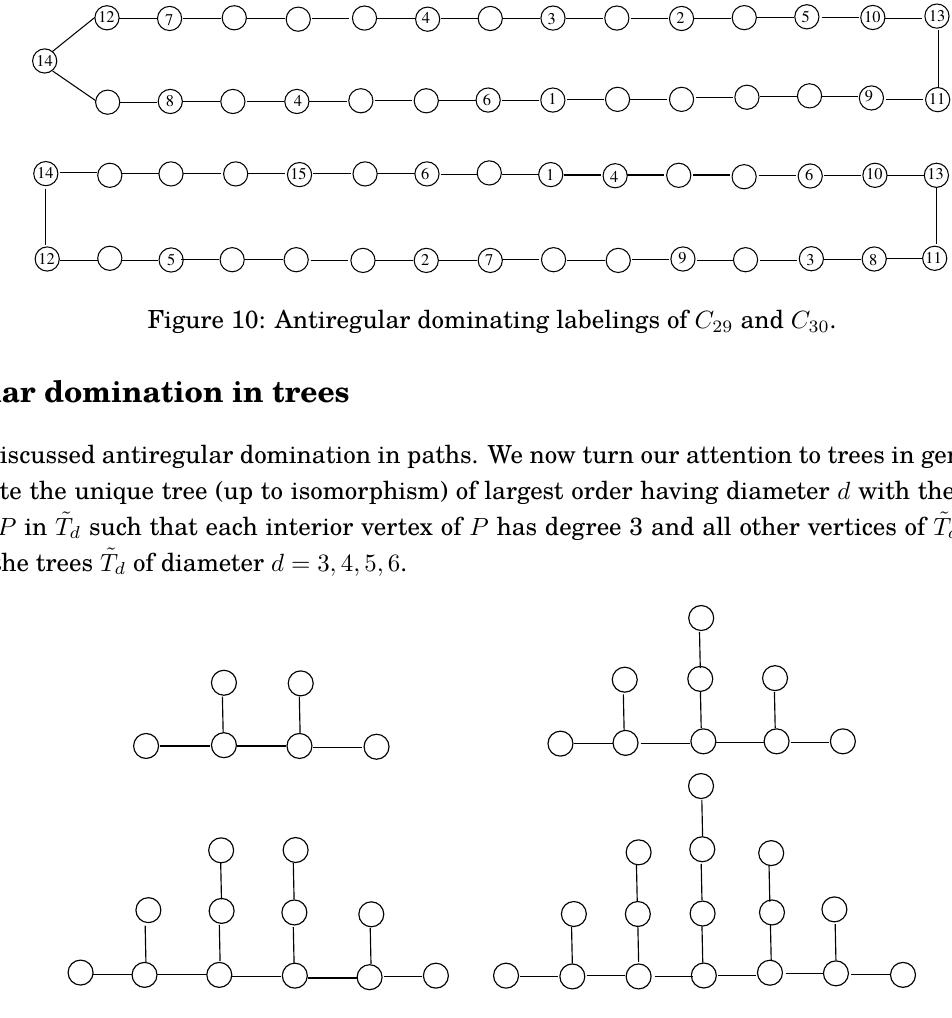
of diameter d = 3 , 4 , 5 , 6 d